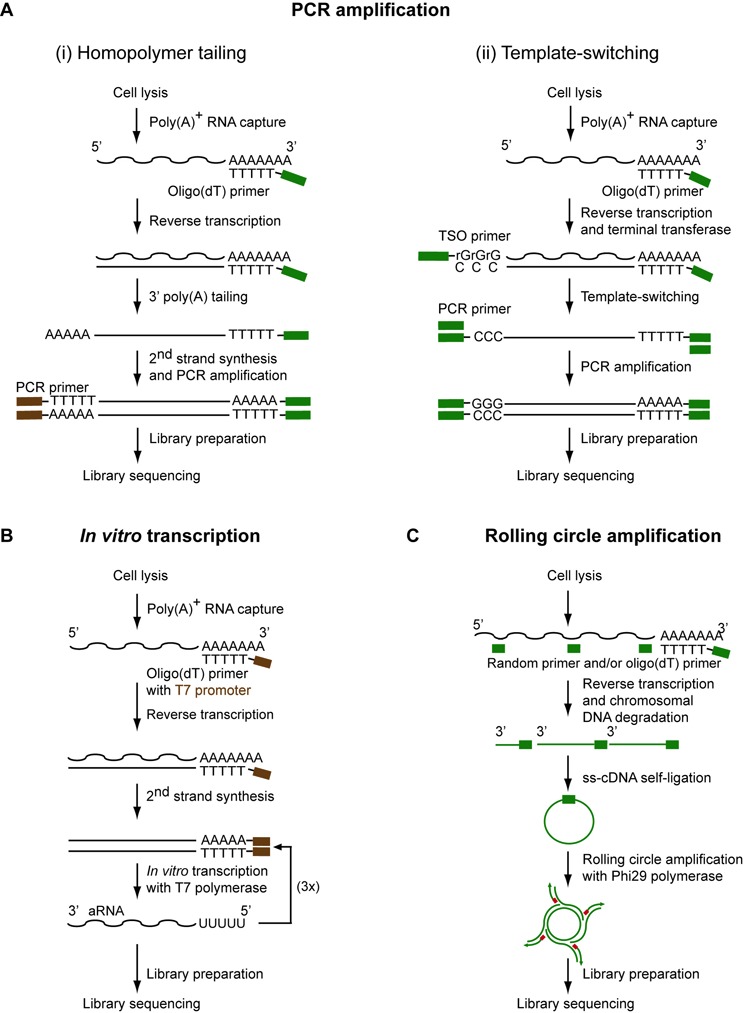
Existing methods to prepare sequencing libraries from a single cell. The methods differ with respect to the strategy used to amplify cDNA that is obtained by oligo(dT)- or/and random-primed reverse transcription. (A) Universal primers are inserted at the 3′ end along with the reverse transcription initiation oligonucleotide and at the 5′ end of the initial RNA molecules after reverse transcription via either (i) poly(A) tailing at the 3′ end of the first cDNA strand or (ii) template-switching mechanism involving a template-switching oligonucleotide (TSO). (B) During cDNA synthesis, a T7 RNA polymerase primer can be integrated that enables the further amplification of RNA via in vitro transcription. This results in an antisense RNA (aRNA) that can be subjected to library preparation and sequencing. (C) Alternatively, after cDNA synthesis and chromosomal DNA degradation, cDNA can be circularized and amplified by a technique referred to as rolling circle amplification using the Phi29 polymerase.